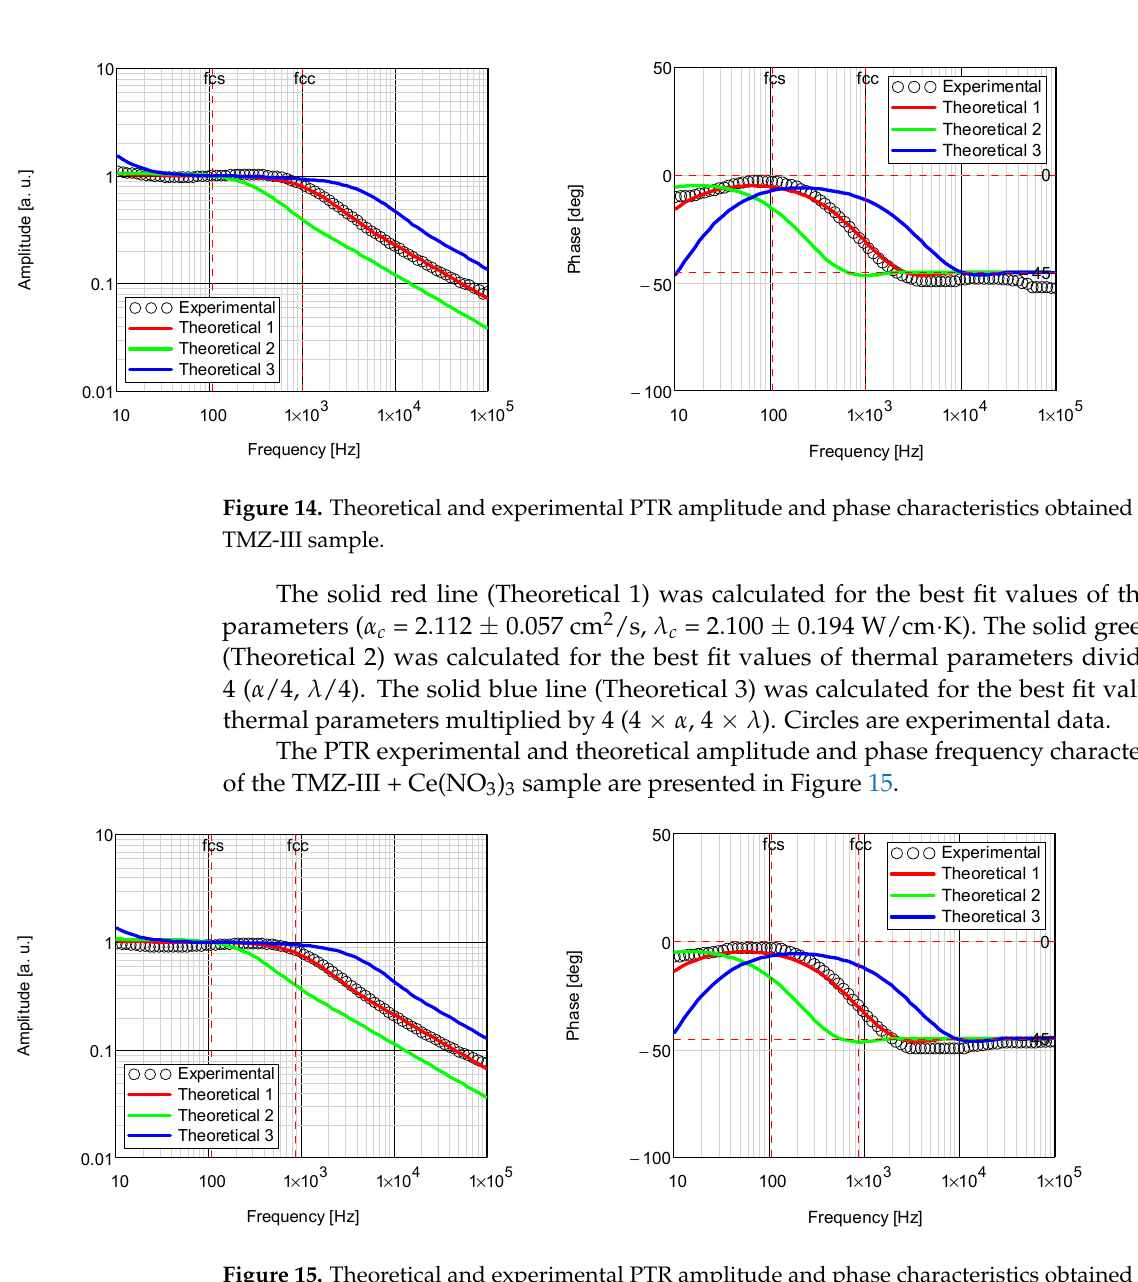
parameters ( α c = 1.838 ± 0.070 cm 2 /s, λ c = 1.710 ± 0.167 W/cm · K). The solid green rameters ( α c = 1.838 ± 0.070 cm 2 /s, λ c = 1.710 ± 0.167 W/cm ∙ K). The solid green line (Theo-